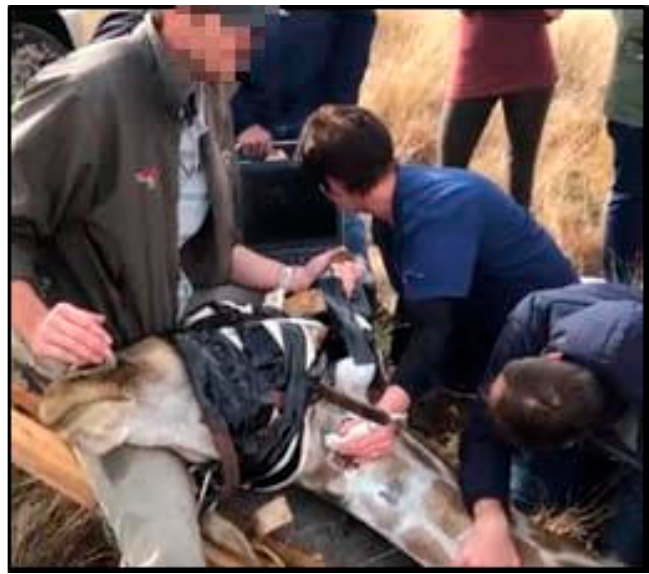
Figure 1. Sonar measurement of the jugular vein and carotid artery with head-down position, measured at the medial aspect of the neck in a distal position.